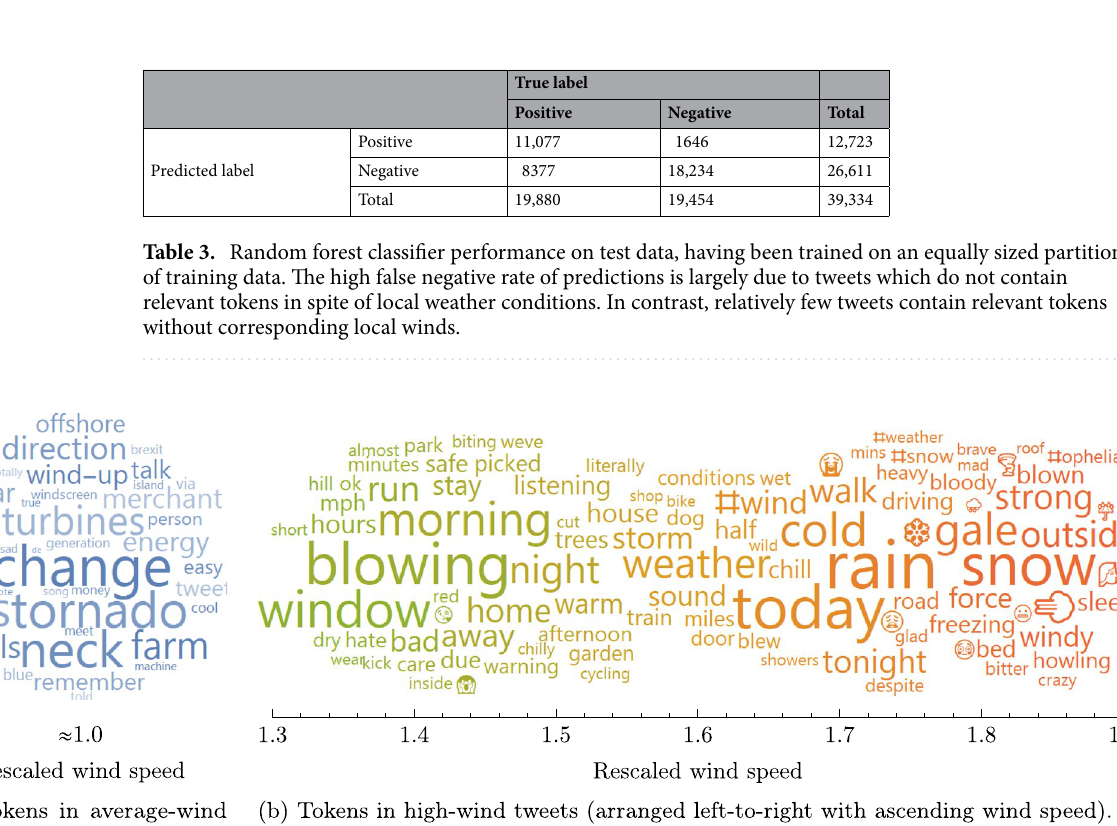
Figure 7. Linguistic tokens ordered by wind speed. Tokens are positioned left-to-right by increasing wind speed (interpreted as the median value from the distribution of locally rescaled wind speeds associated with tweets containing the token). The size of each token indicates the frequency of its use in wind-related tweets. Only the most commonly used tokens are shown. The token ‘tornado’ is associated with average wind speeds because tornadoes are extremely rare in the UK and these tweets are invariably discussing tornadoes in other